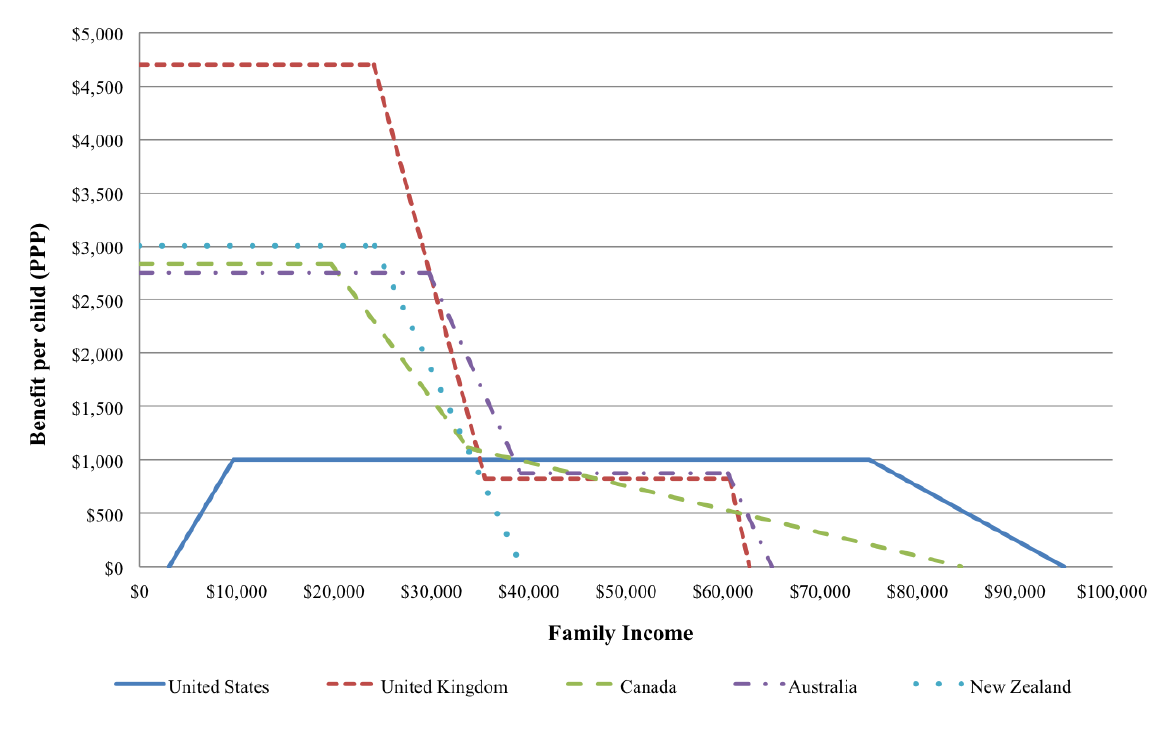
Figure 1: Child tax credit parameters in liberal welfare regimes